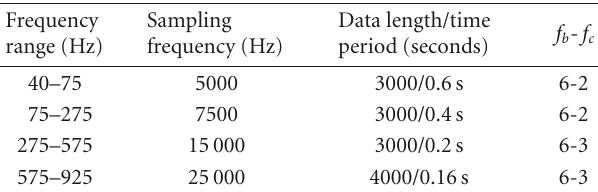
Table 2: Settings of the proposed detection